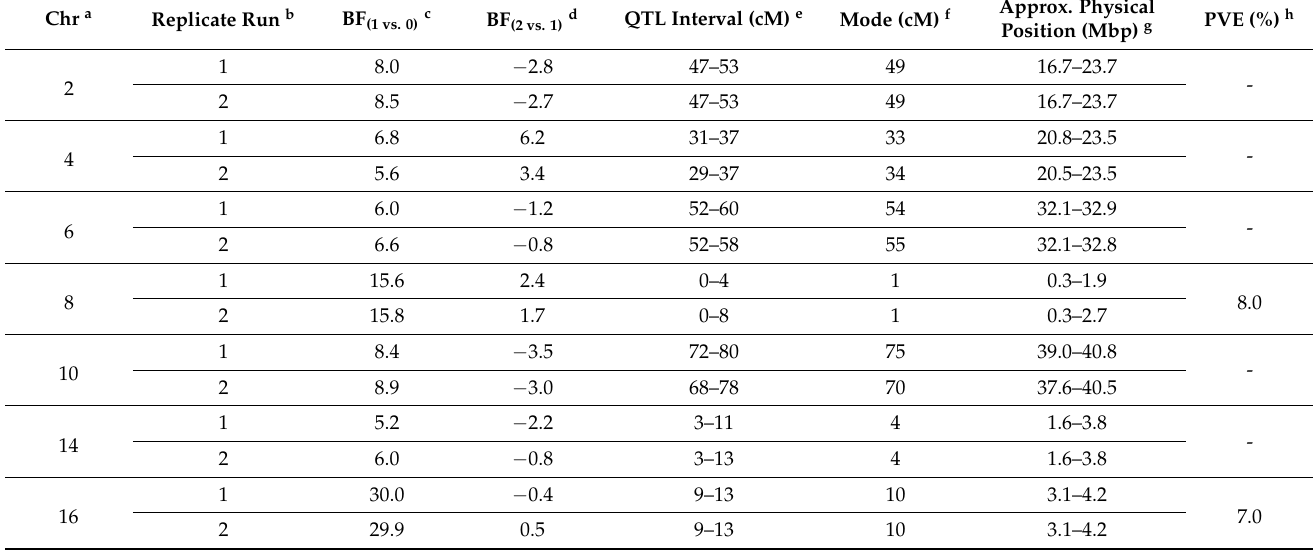
Table 2. Summary of fruit weight QTL analysis in pedigree-connected apple germplasm representing 14 breeding parents. Across year fruit weight best linear unbiased predictions (BLUPs) were used as phenotypic values. Results are shown for two FlexQTL™ replicate software